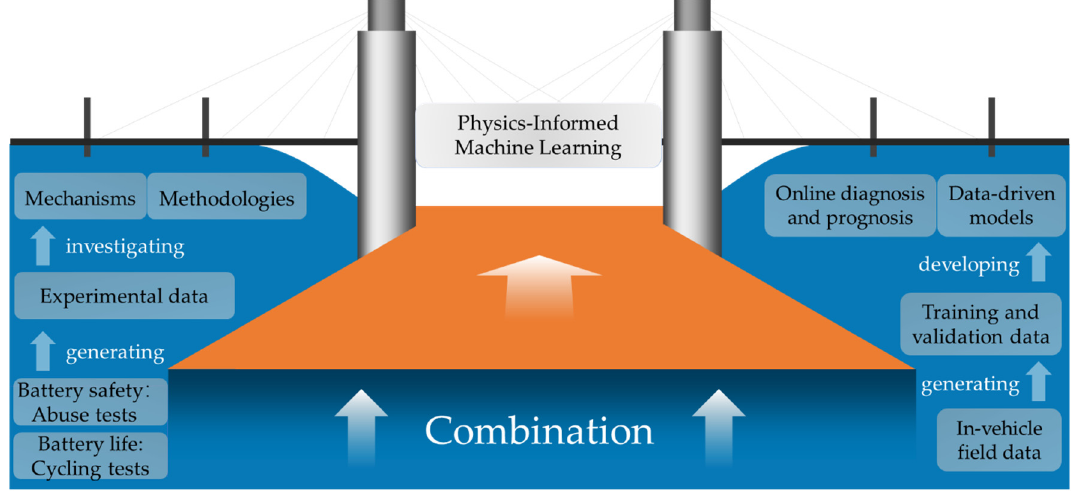
Figure 6. Combination of physics-informed modelling with in-vehicle battery data.